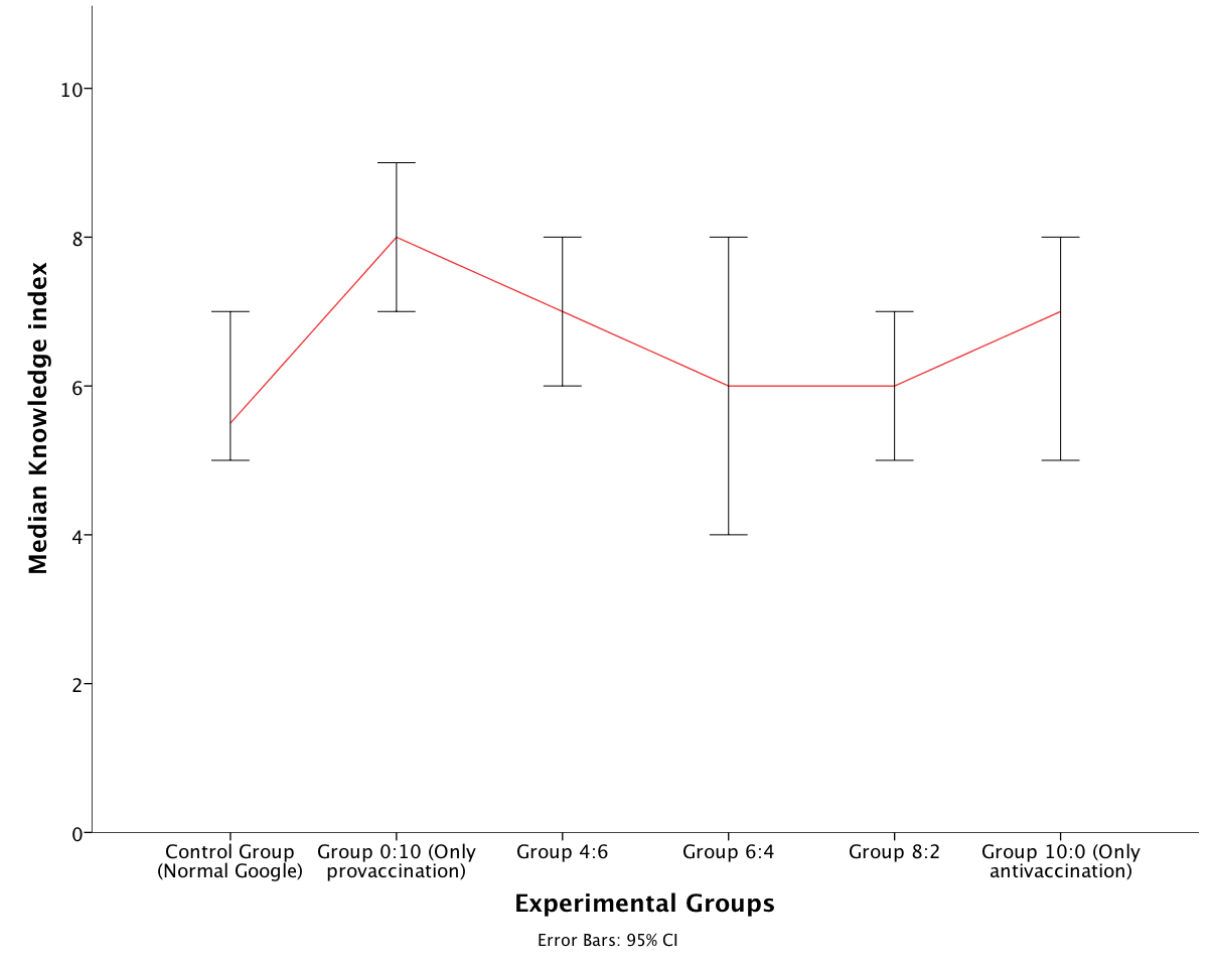
Figure 2. Median vaccination knowledge scores and 95% CI (error bars) by experimental group (experiment